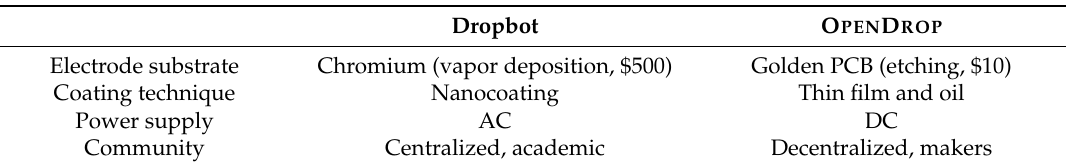
Table 1. Comparison between Dropbot and O PEN D ROP